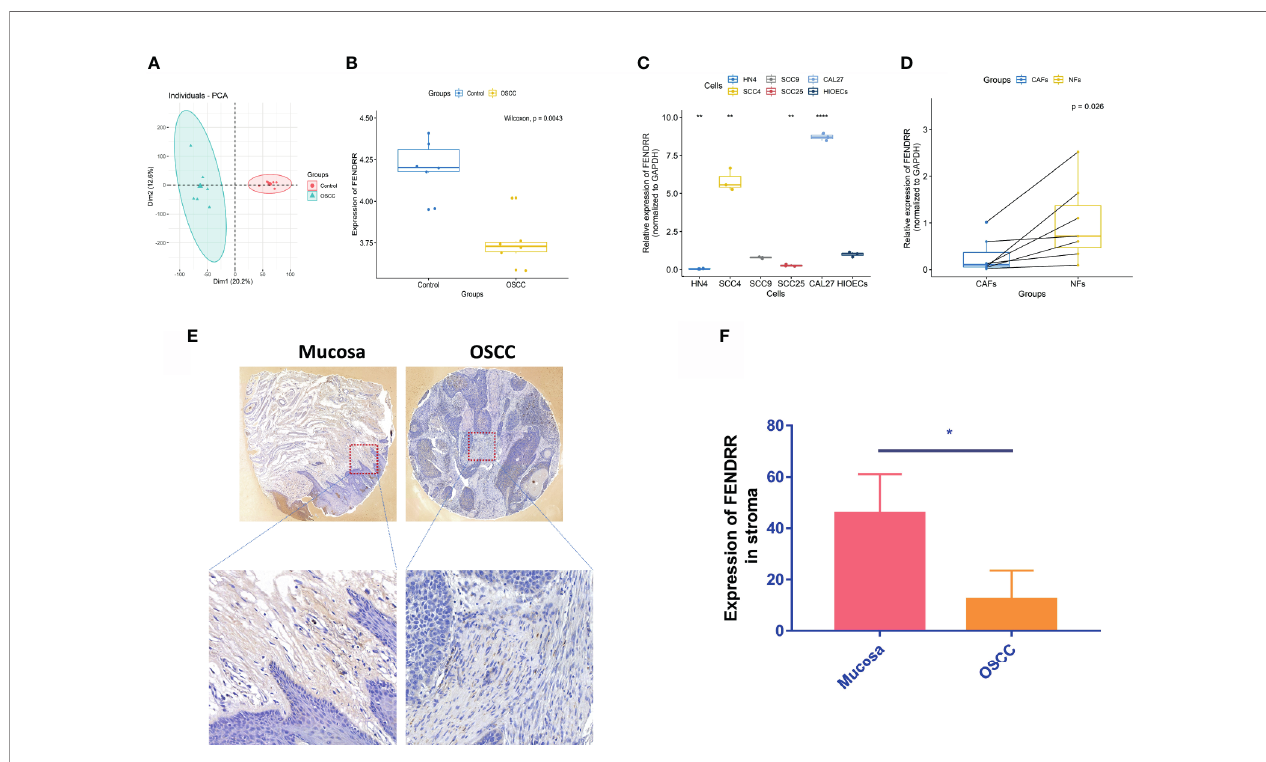
FIGURE 2 | Gene expression analyses of FENDRR. (A) 12 groups of data from the GSE9844 dataset were selected through PCA. (B) Selected 12 groups were used for differential expression analysis of FENDRR in OSCC and negative control. (C) Real-time PCR was used to detect the expression of FENDRR in SCC4, SCC9, SCC25, CAL27, HN4, and HIOECs. (D) Real-time PCR was used to detect the expression of FENDRR in 7 pairs of CAFs and NFs derived from OSCC tissues. (E, F) The expression of FENDRR in 4 pairs of OSCC and mucosal tissues was detected using ISH. * P < 0.05, ** P < 0.01, **** P <